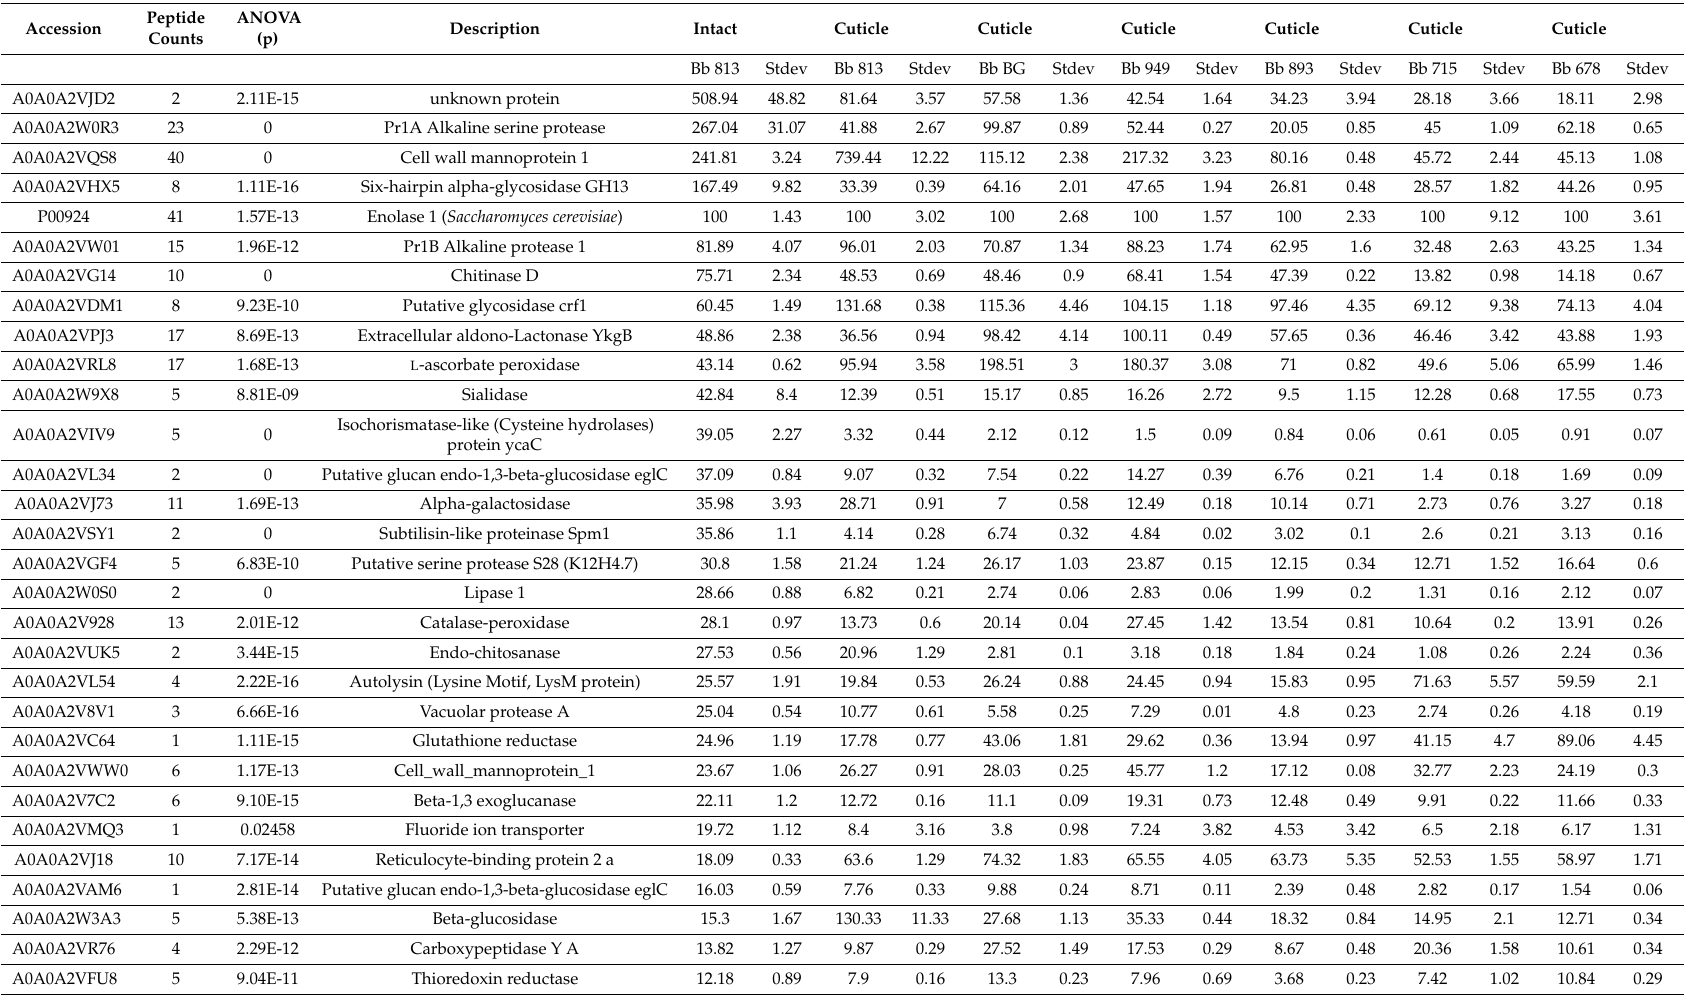
Table 2. Absolute quantification of differentially secreted proteins from B. bassiana isolates under different growth conditions in liquid medium. Isolate Bb 813 was grown both in intact cockroach medium (“intact”) and in isolated cuticle medium (“cuticle”) used also for the other isolates. Progenesis QI for proteomics results have been ENO1 normalized and proteins sorted by their absolute amount calculated in fmol/ µ